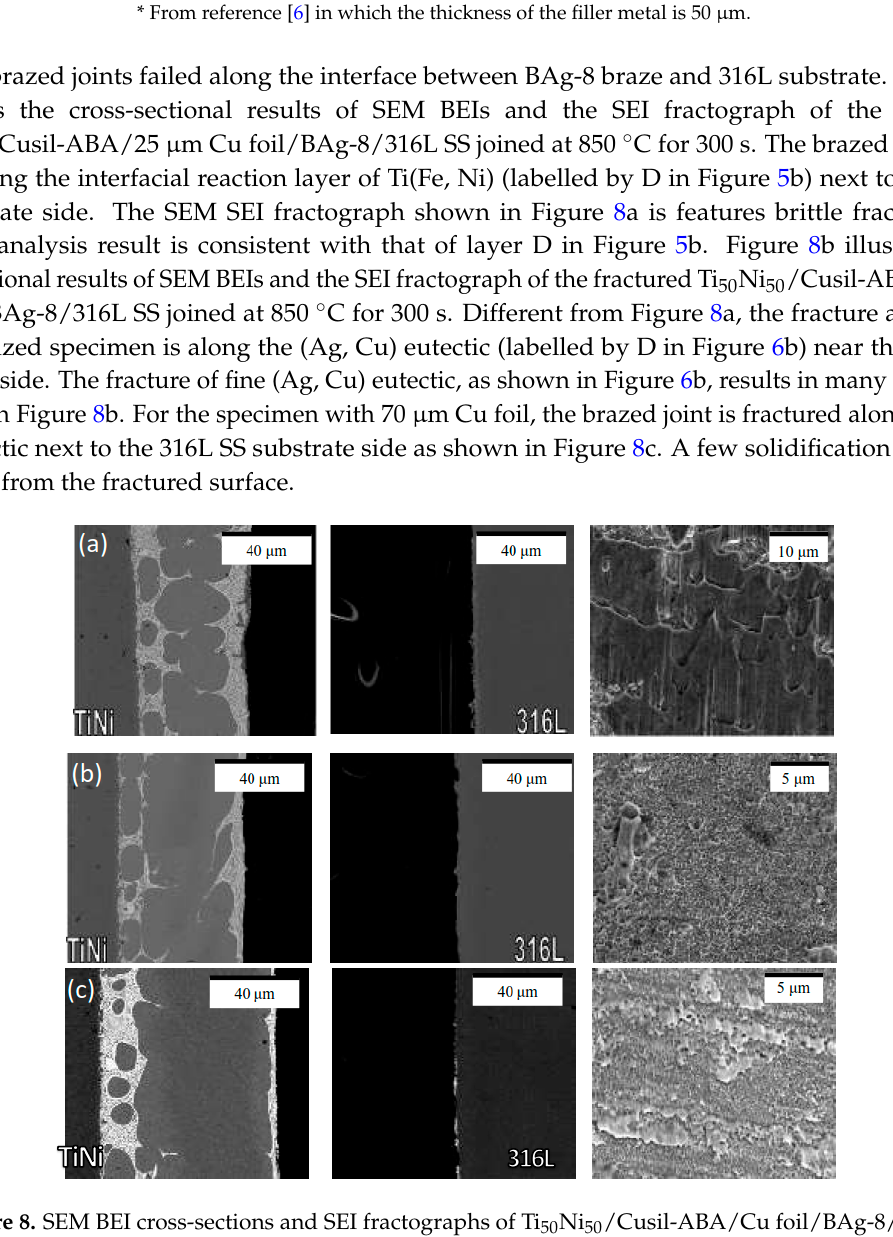
Table 5. Average shear strengths of infrared brazed Ti 50 Ni 50 SMA and 316L SS joints.